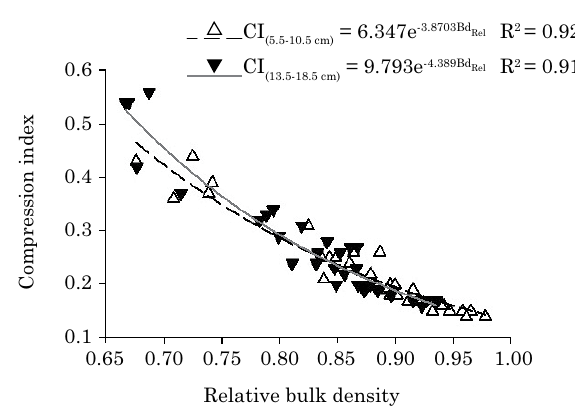
figure 2. Correlation of relative density (Bd rel ) and compression index (CI) in the 5.5-10.5 cm and 13.5-18.5 cm layers of a Rhodic